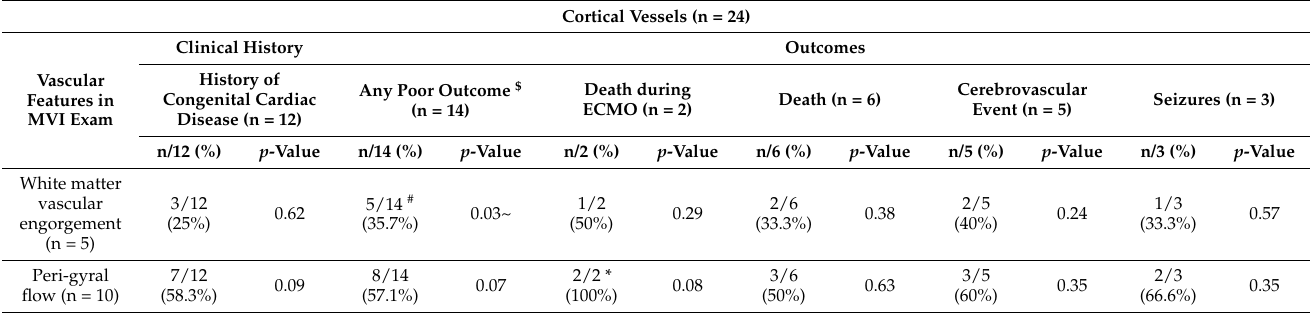
Figure 6. A 6-month-old boy with a history of hypoplastic left heart syndrome underwent ECMO due to failure to wean from cardiovascular bypass after major cardiac surgery. Brain MVI was performed after nine days from cannulation; grayscale US (not shown) demonstrated a hyperechogenic focus within the right posterior temporal lobe/occipital lobe, concerning for hemorrhage. Coronal brain MVI demonstrates very marked peri-gyral. The patient passed away while on ECMO, nine days after cannulation. Table 2. Evaluation of cortical microvessels with microvascular imaging ultrasound.